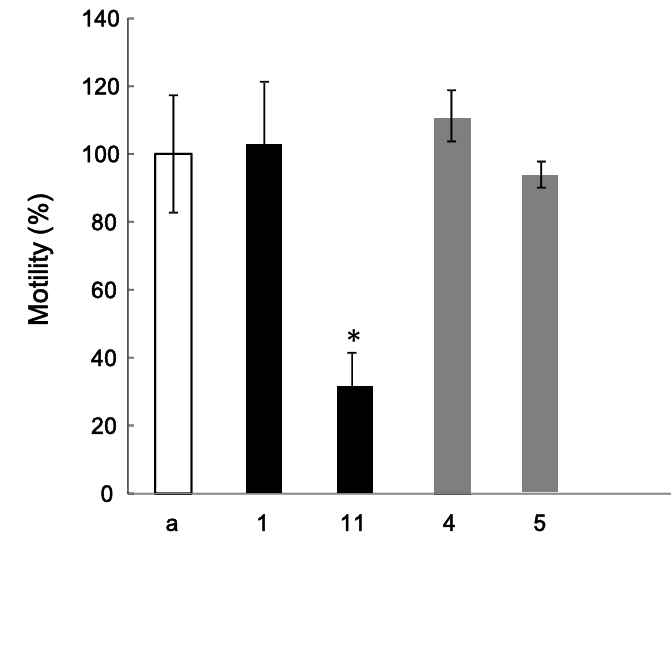
Figure 3. Effect of compounds 1 , 4 , 5 , and 11 on the HGF-induced motility of MDA-MB-231 cells. The cells were suspended in DMEM (a) alone or with 1 , 11 , 4 , or 5 ( 1 and 11 : 4 μ g/mL, 4 and 5 : 10 μ g/mL), and poured into the upper well of the Transwell. The lower well contained 600 µL of DMEM containing 50 ng/mL HGF. At 20 h, the cells migrating into the lower well were counted. * p < 0.05 vs . the